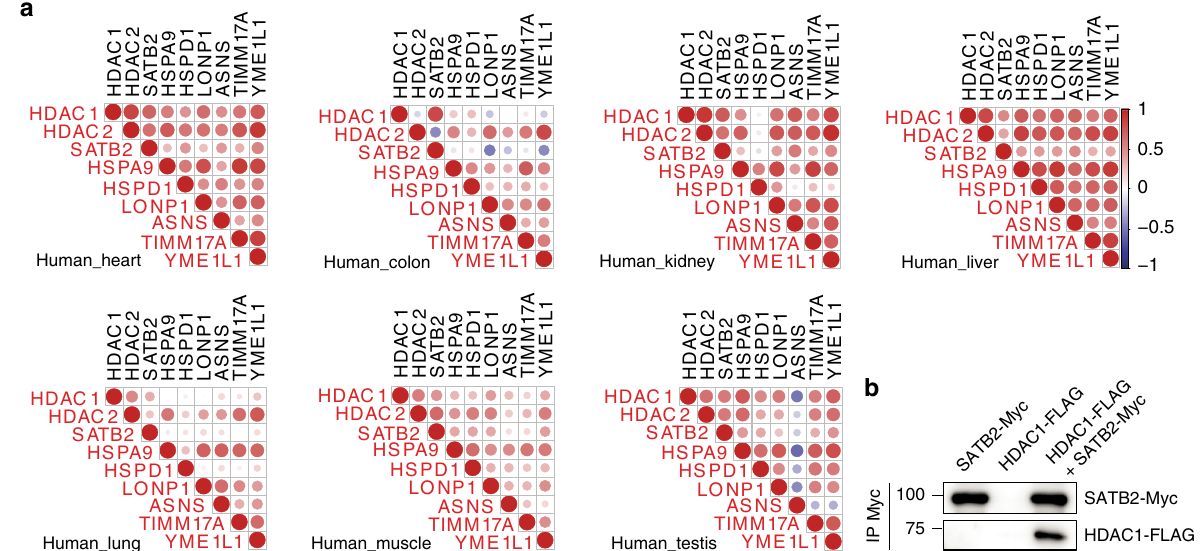
Fig. 5 Transcript levels of human HDAC1/2 strongly correlate with the expression of UPR mt genes. a Pearson ’ s correlation of HDAC1, HDAC2, SATB2 and UPR mt mRNA levels in human heart, colon, kidney, liver, lung, muscle, and testis tissues. Red circles indicate positive correlation and blue circles indicate negative correlation. The size of the circle corresponds to the correlation coef fi cient. b Immunoprecipitation followed by immunoblotting shows that HDAC1 interacts with SATB2 in HEK293T cells. Source data are provided as a Source Data fi le.